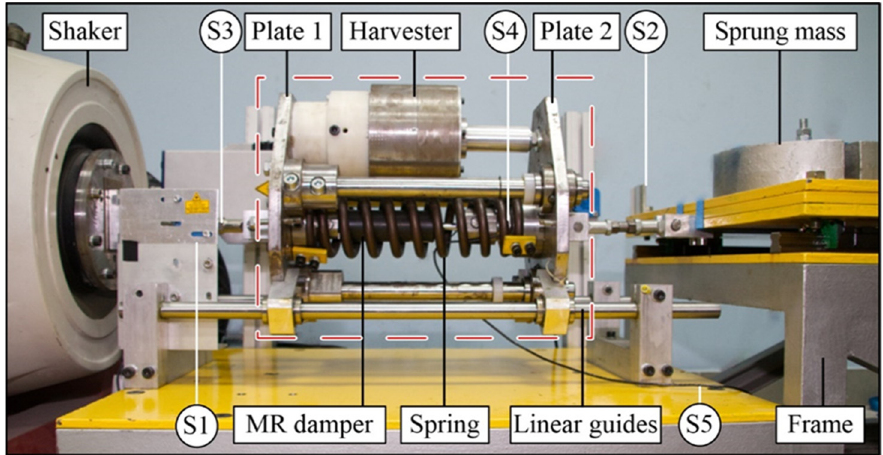
Figure 1. RVR-MRD system installed in the test rig.